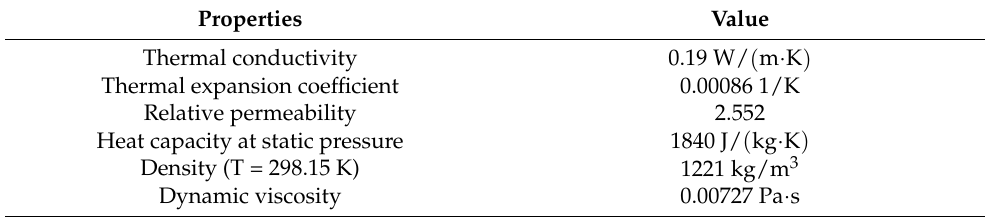
Figure 1. Geometry and figures of the reference model applied in this study. ( a ) 3D configuration of a fin-tube heat exchanger model; ( b ) 2D configuration of a fin-tube heat exchanger model. Table 1. The properties of EFH-1 [13].